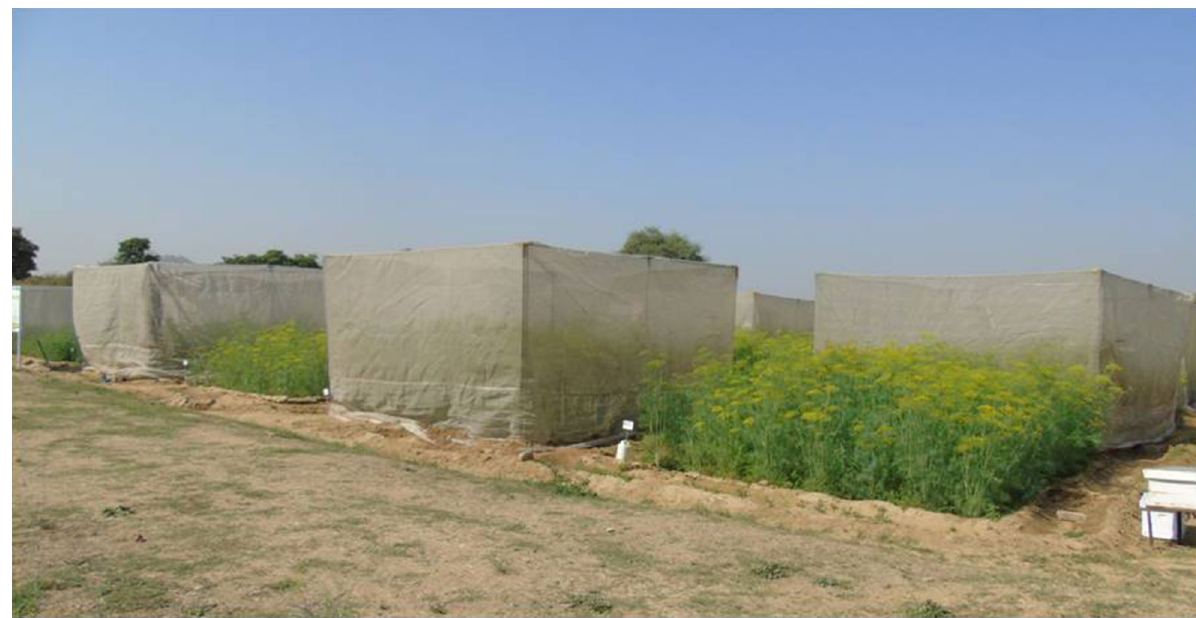
Figure 1. Design of field experiment showing insect cages for pollination study in dill seed